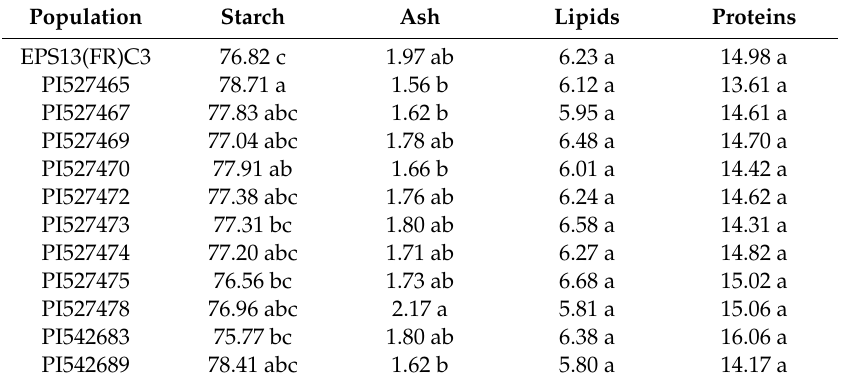
Table 1. Nutritive value 1 (%) of eleven Algerian maize populations and one Spanish